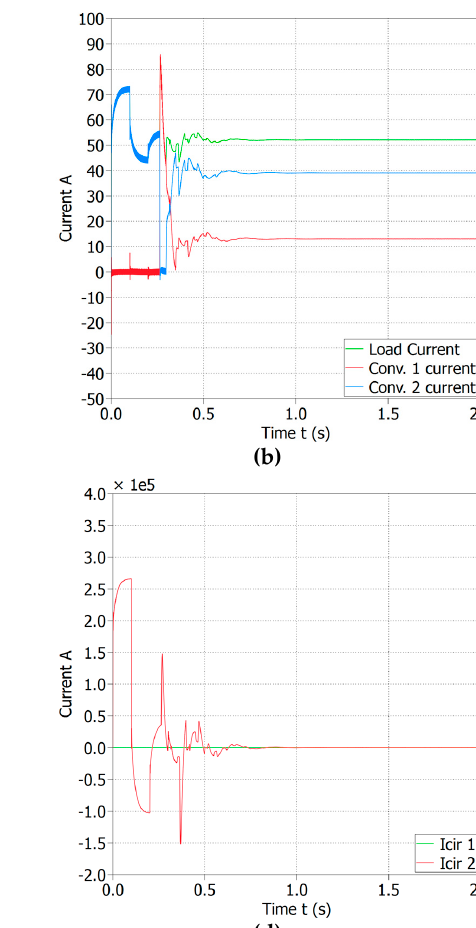
Figure 8. Scenario 2 outputs with load resistance of 0.9216 Ω , K 1 = 1 and K 2 = 2, Rline1 = Rline2 = 0.0001 Ω , 𝜏 (cid:3031)(cid:3046) = 5 𝑚𝑠 , ( a ) Converters’ output voltages and the load voltage, ( b ) Converters’ output currents and the load current, ( c ) Converters’ output power and the load power, ( d ) Circulating currents.